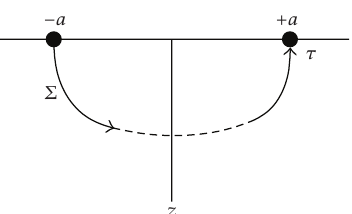
Figure 17: The curve Σ ⊂ AdS connecting the two-points in C . The arrows on the curve indicate the orientation, created by Vijay